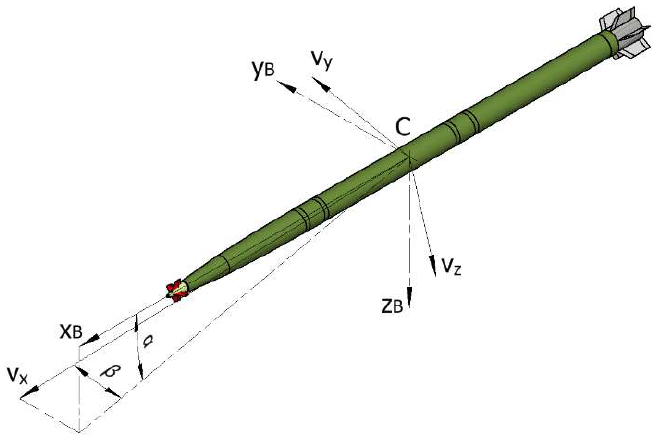
Figure 3. Velocity and BFP Frame.